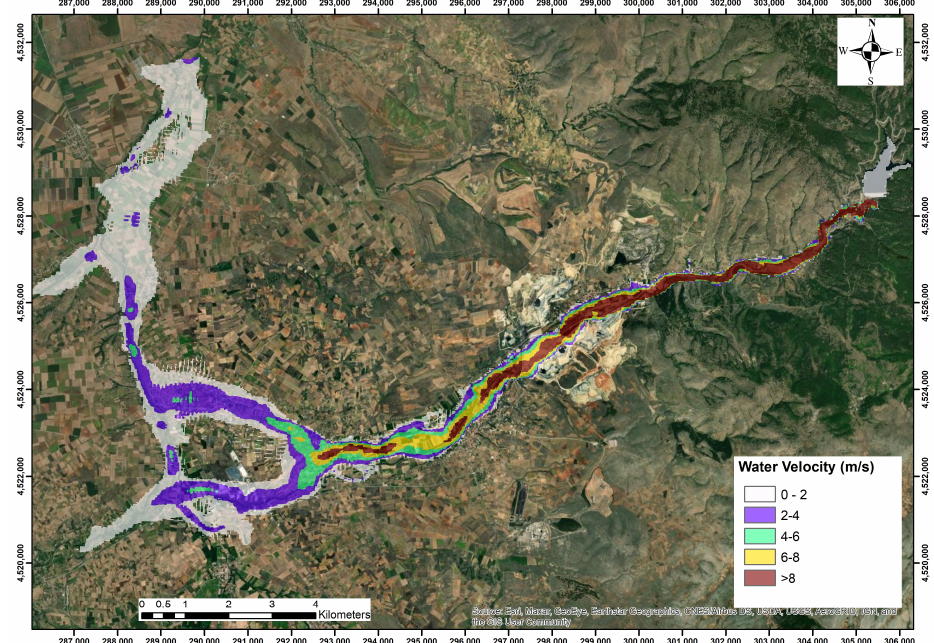
Figure 15. Maximum water velocity and boundaries of inundated area in the case of the overtopping dam failure.